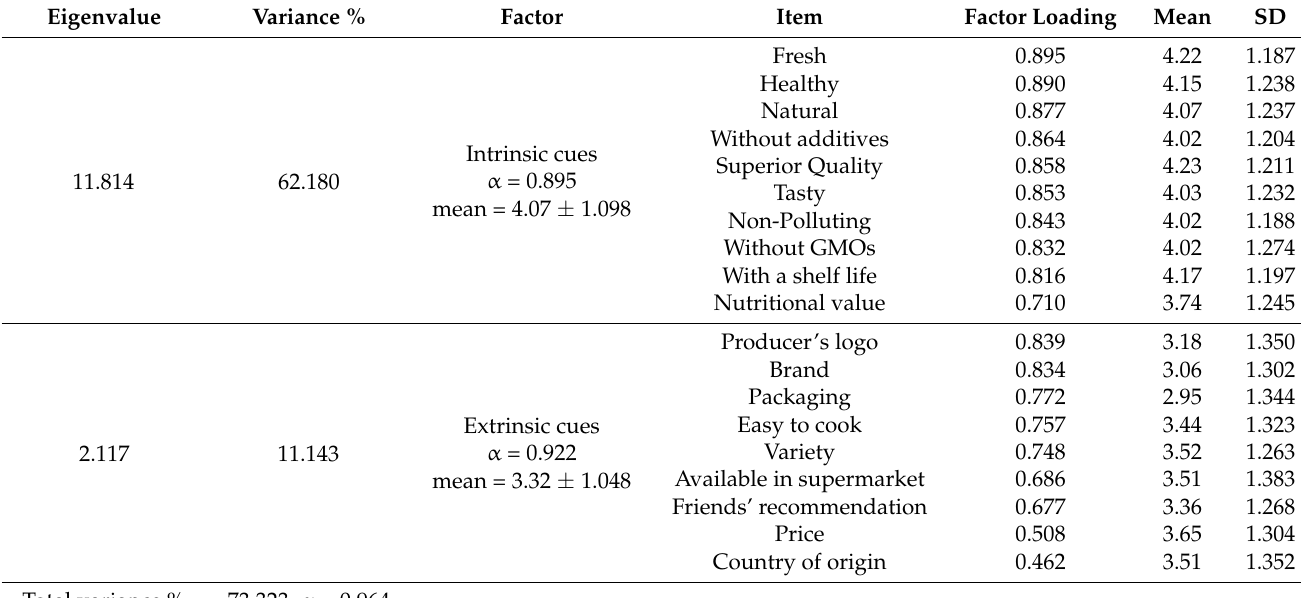
Table 2. The two factors resulting from the PCA analysis with the corresponding